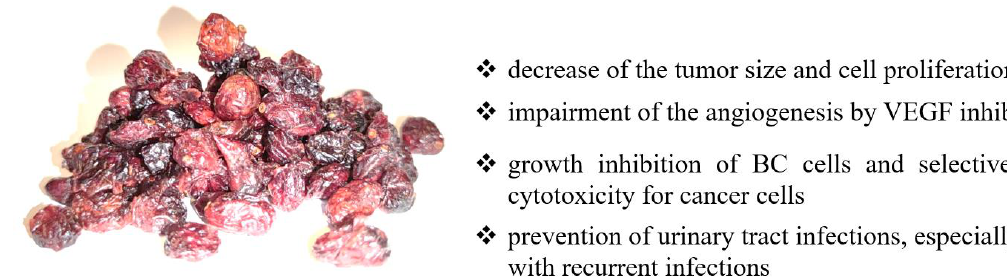
Figure 2. The summary of anticancer effects and mechanisms of cranberry action. Cranberry may modulate numerous signaling pathways, including angiogenesis [89], growth and proliferation [89], and inflammation